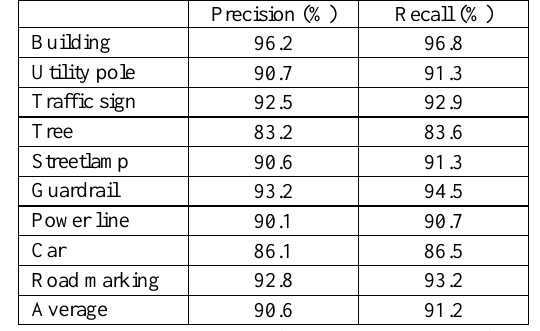
Figure 10. Details of the road surface features extraction results: (a) extraction result of irregular road markings, (b) extraction result of road markings with various intensities, and (c) extraction result of road markings from very nosiy point cloud.